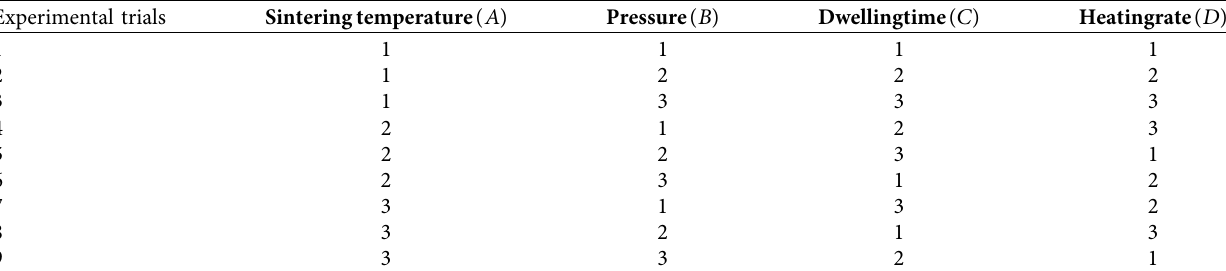
Table 1: Taguchi’s L